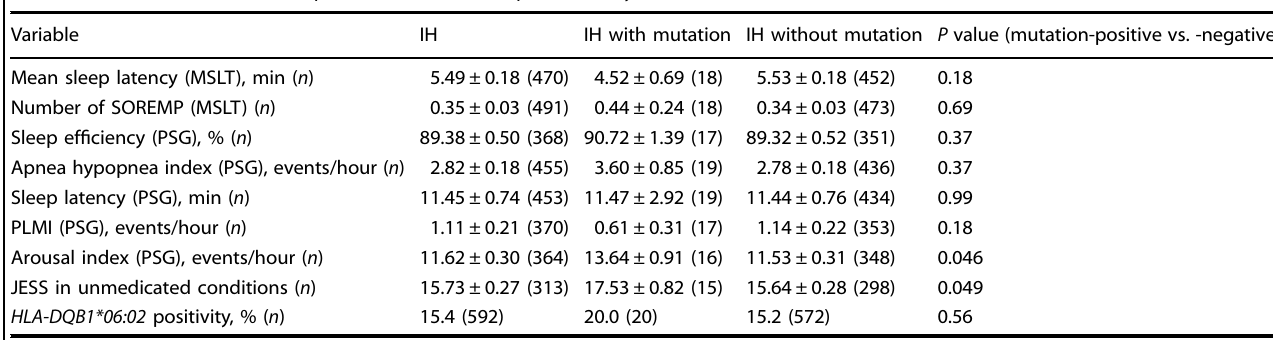
Table 2. Clinical characteristics of patients with IH in the present study. Variable IH IH with mutation IH without mutation P value (mutation-positive vs.